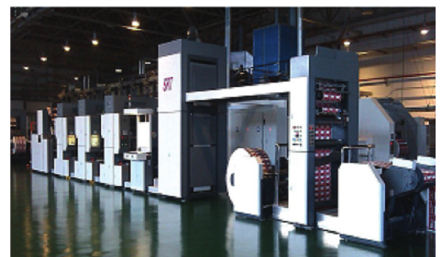
Figure 1: Industrial printing production equipment.